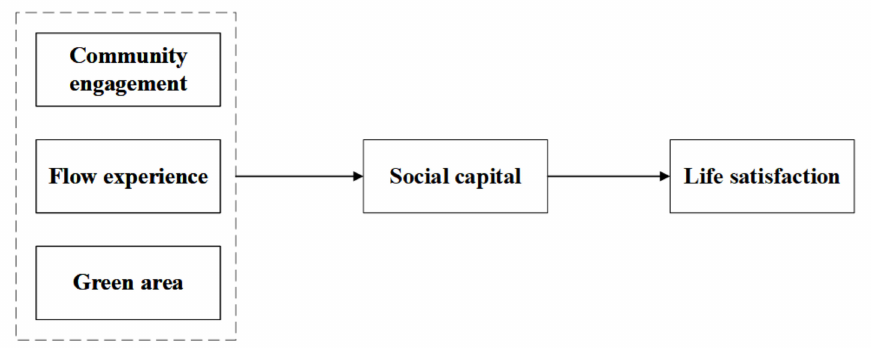
Figure 2. The mediation model: social capital as a mediator. Hypothesis 2 (H2a) : Social capital mediates the relationship between community engagement and life satisfaction (innovative